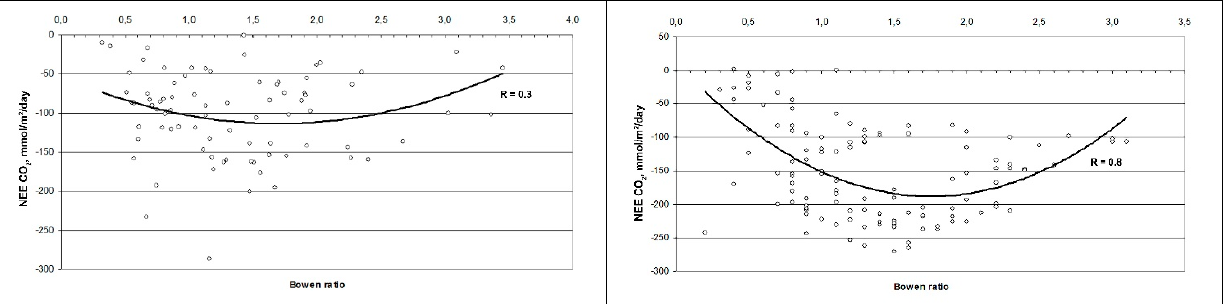
Figure 7. The relationship between NEE and Bowen ratio in the Gmelin larch ( left ) and Scots pine ( right ) ecosystems for the growing